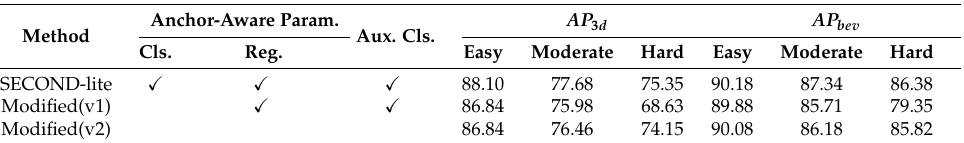
Table 9. From anchor-based to anchor-free methods. SECOND-lite is an anchor-based 3D detector. Our method (v1) uses Gaussian labeling for the target assigner and keeps the same regression branch and auxiliary direction classification branch. The v2 model does not use any anchor-related parameters during training and inference.